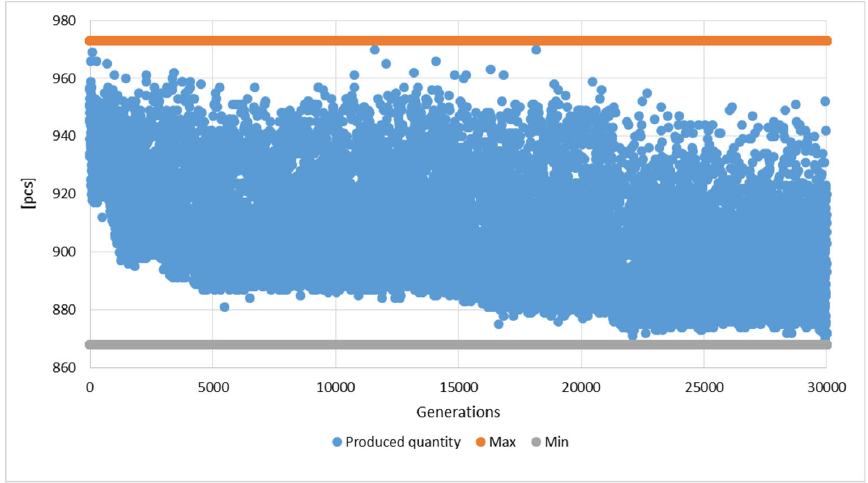
) (cid:2869) the sum of the remaining time ( 𝑓 (cid:2870)